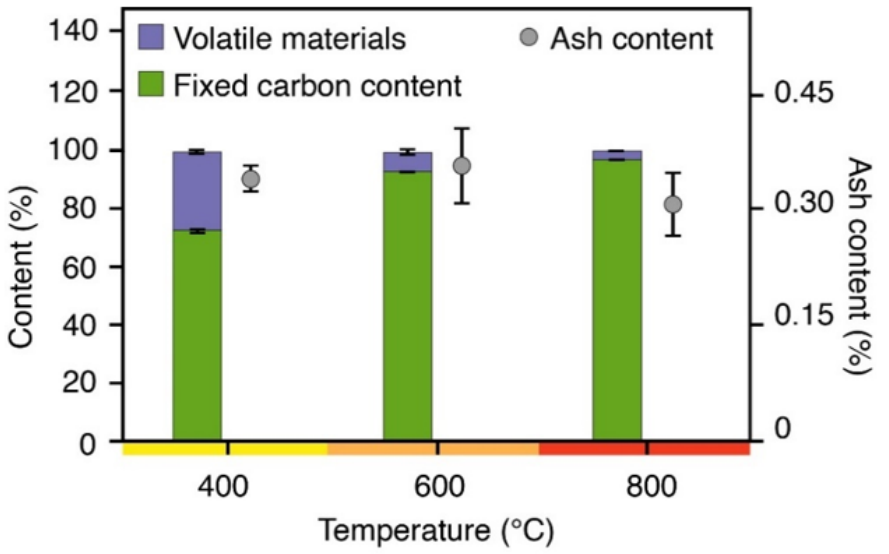
Figure 2. Immediate chemical composition of charcoal fines. Source: Where: FC = fixed carbon content; VM = volatile material content; AS = ash content.